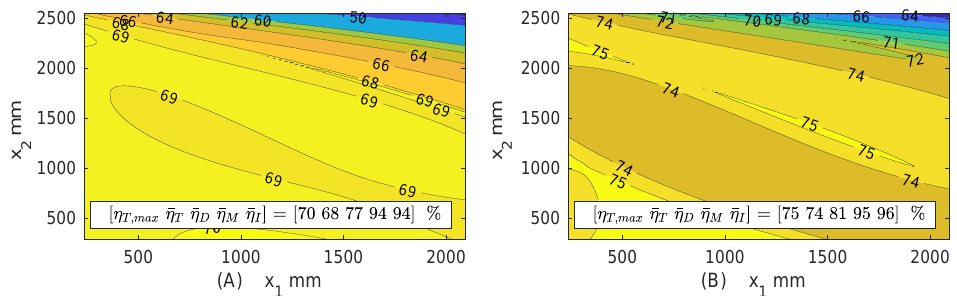
Figure 20. Efficiency for VDN-LS in crane application with interconnection scheme 1 ↔ 23 ↔ 4 and 0 ↔ 23. ( A ) total efficiency under payload extension, − ˙ x under payload retraction, ˙ x 1, max = − ˙ x 2, max = 50 mm/s. ¯ η D , ¯ η M , ¯ η I , ¯ η T , η T,max corresponds to the mean displacement unit, motor, inverter, total efficiencies, and maximum total efficiency.